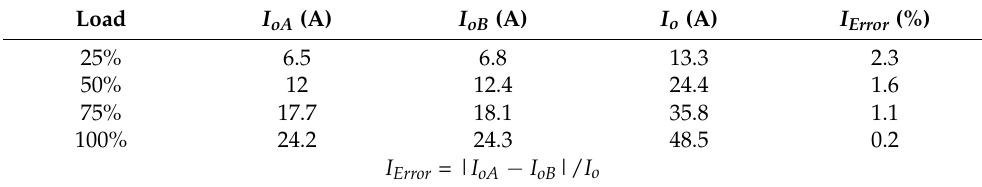
Figure 23. Output current waveforms of the two modules in parallel at ( a ) 50%, ( b ) 75% and ( c ) 100% load.